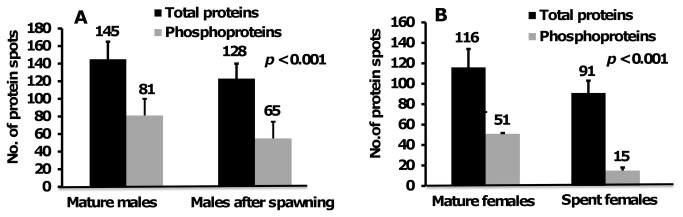
The number of protein and phosphoprotein spots detected in (a) mature males (MM), males after first spawning (MAS) and (b) mature females (MF), and spent females (S) of

N

. arenaceodentata
.The protein spots were determined by a paired t-test with p-value (p < 0.001) using PDQuest software (version 8.0). Each error bar represents the mean (SD) number of proteins from three replicate gels.